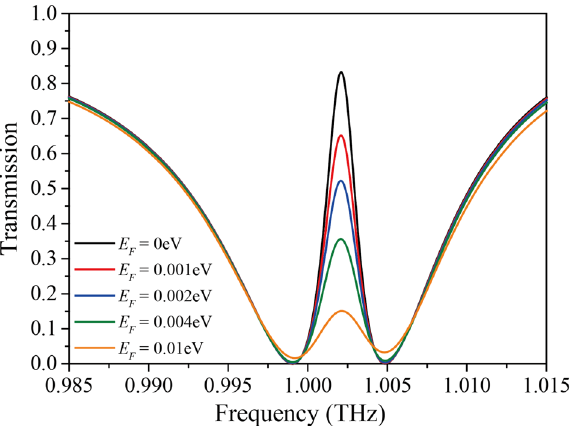
Figure 2. Transmission spectra for Fermi level variation from E F = 0–0.01 eV. The period structure is a = 218 μm, and the width and height of the photonic crystal are w pc = 0.7 a , and t pc = 0.2 a , respectively. The thicknesses of the top and bottom waveguides are t 1 = 0.25 a and t 2 = 0.361 a , respectively, and the gap size is g = 0.8 a